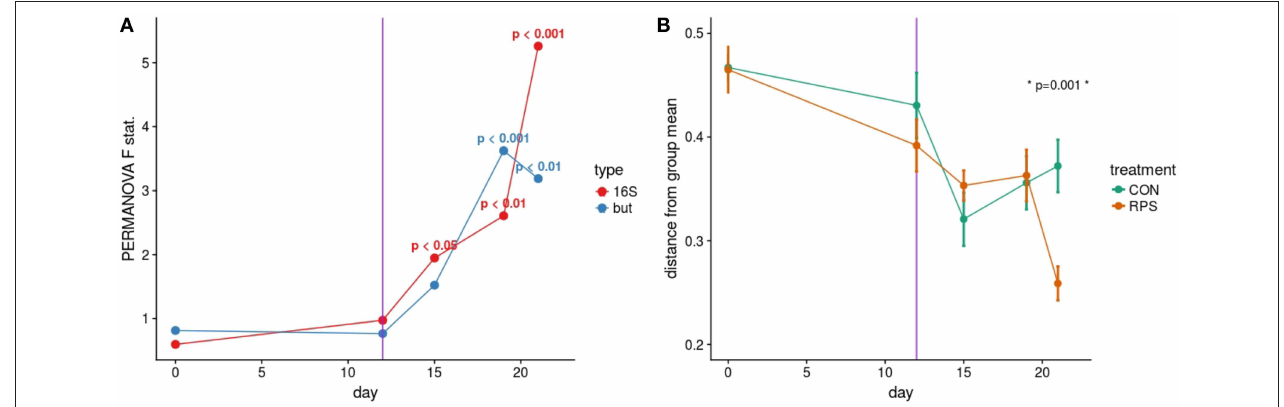
FIGURE 1 | (A) PERMANOVA pseudo F statistic over time for both the 16S- and but gene-based fecal bacterial community analyses. A Bray-Curtis dissimilarity matrix was calculated from a rarefied set of OTUs clustered at 97% identity, and this dissimilarity matrix was used as the input for the PERMANOVA tests. Each data point represents the PERMANOVA test statistic (F: intergroup dissimilarity/intragroup dissimilarity) comparing the CON and RPS fecal bacterial community structure at each time point; higher values equate to greater differences between treatment groups. P -values are shown when p < 0.05. (B) Group dispersion over time. Higher values on the Y axis indicate that communities within that group are more dissimilar from each other. Lower Y axis values indicate that communities in that group are more similar to each other. Error bars represent the standard error around the mean. The vertical purple line indicates a dietary phase